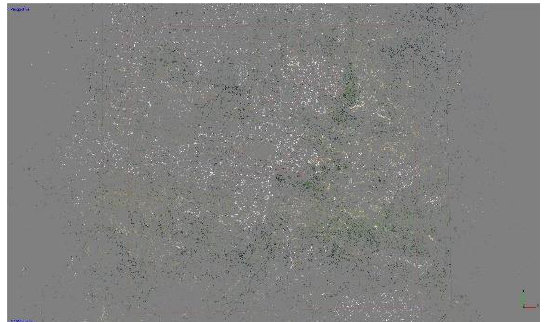
Figure 6 Align photo